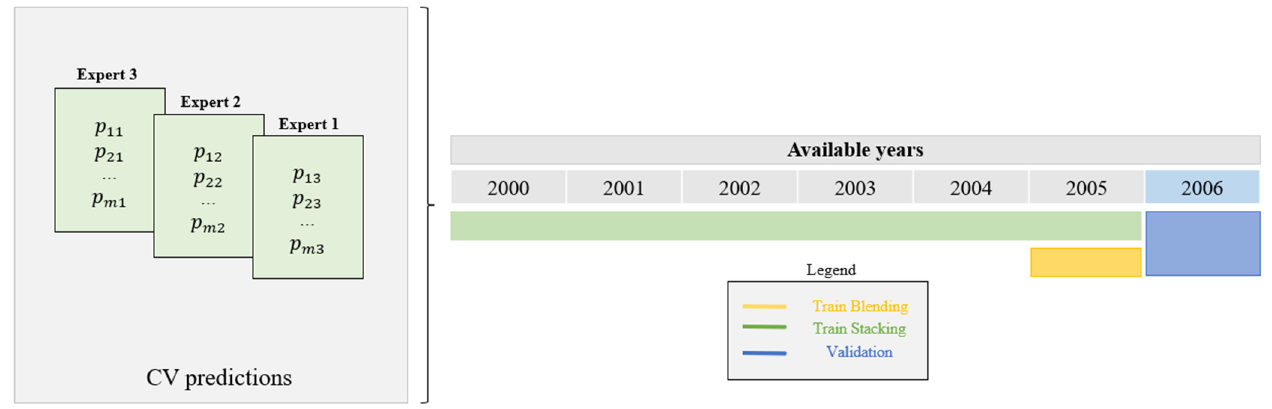
Figure 3. Origin of the data set used to train the Stacking and Blending meta-learners.